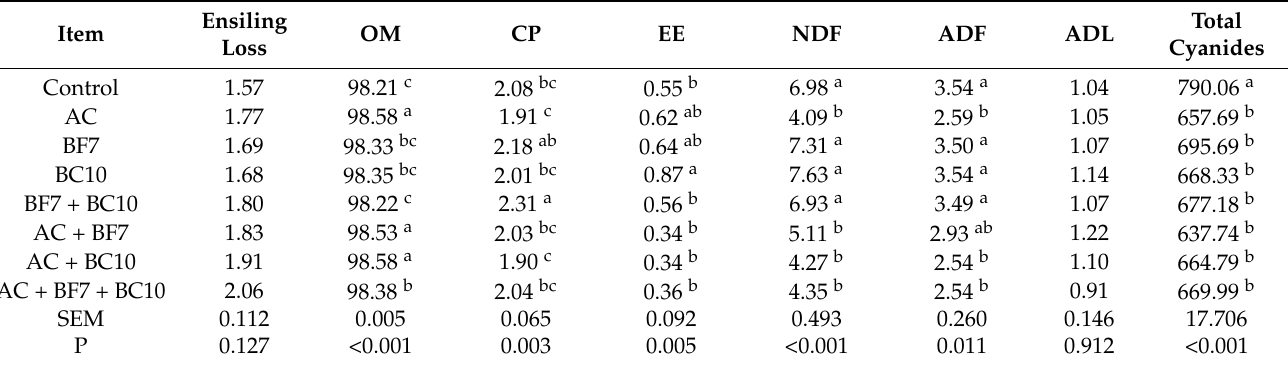
Table 2. Ensiling loss (%), chemical composition (% DM), and total cyanide content (mg/kg DM) of cassava root silage after 30 days of